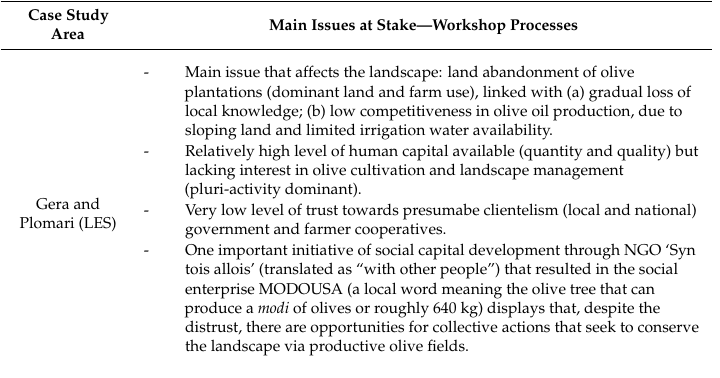
Table 2. Main issues at stake, processes, and discussions in